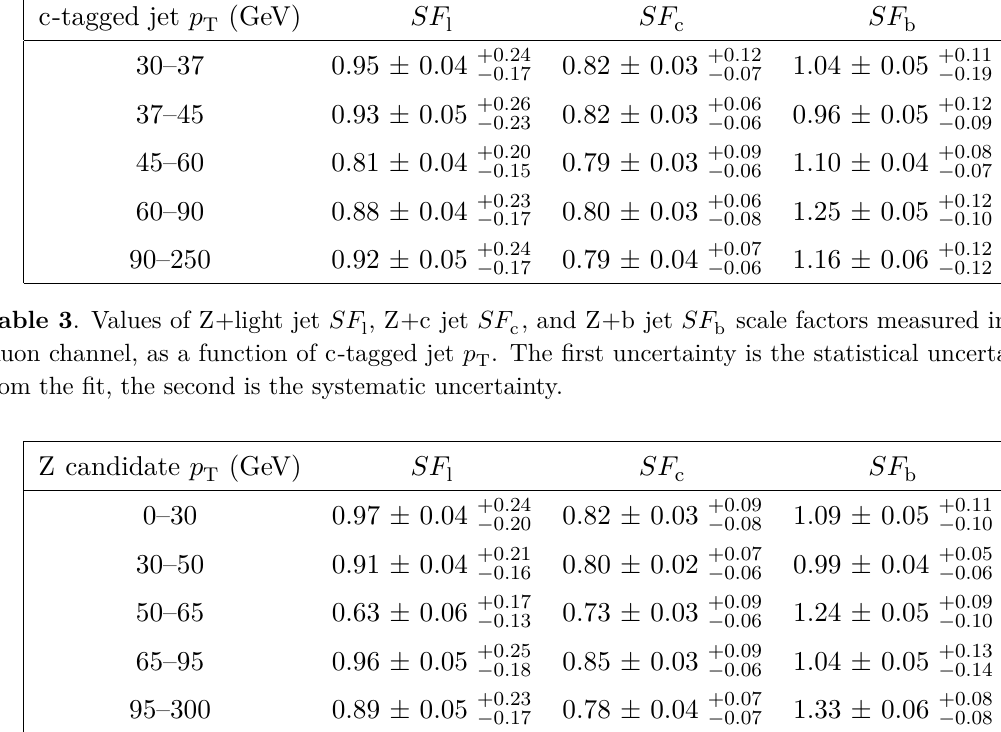
, Z + c jet SF , and Z + b jet SF scale factors measured in the l c b . The first uncertainty is the statistical uncertainty T